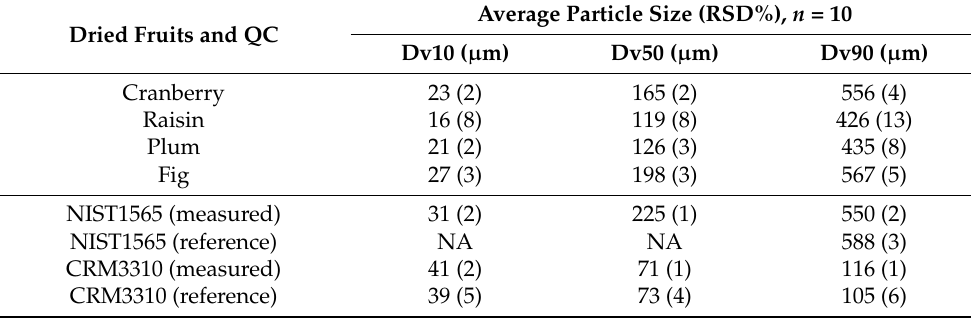
Table 1. Particle size distribution of homogenized dried fruit samples and QC (NIST 1565 and CRM3310).